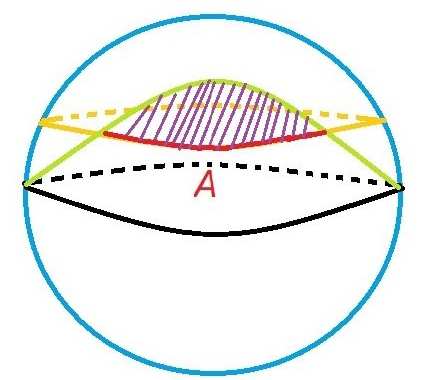
Figure 7 . The cuto(cid:11) slice is orange and part of it | the subsystem A is in red. The RT surface of A is the part of the green great circle over the cuto(cid:11) slice. And the shaded region is the region computing